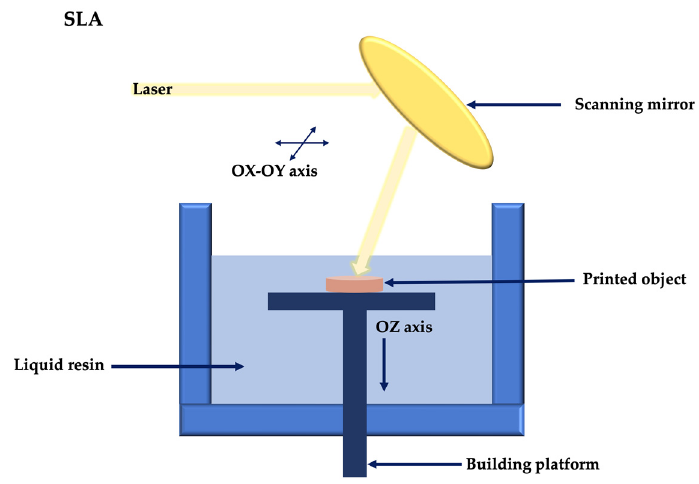
Figure 4. Stereolithography schematic principle.